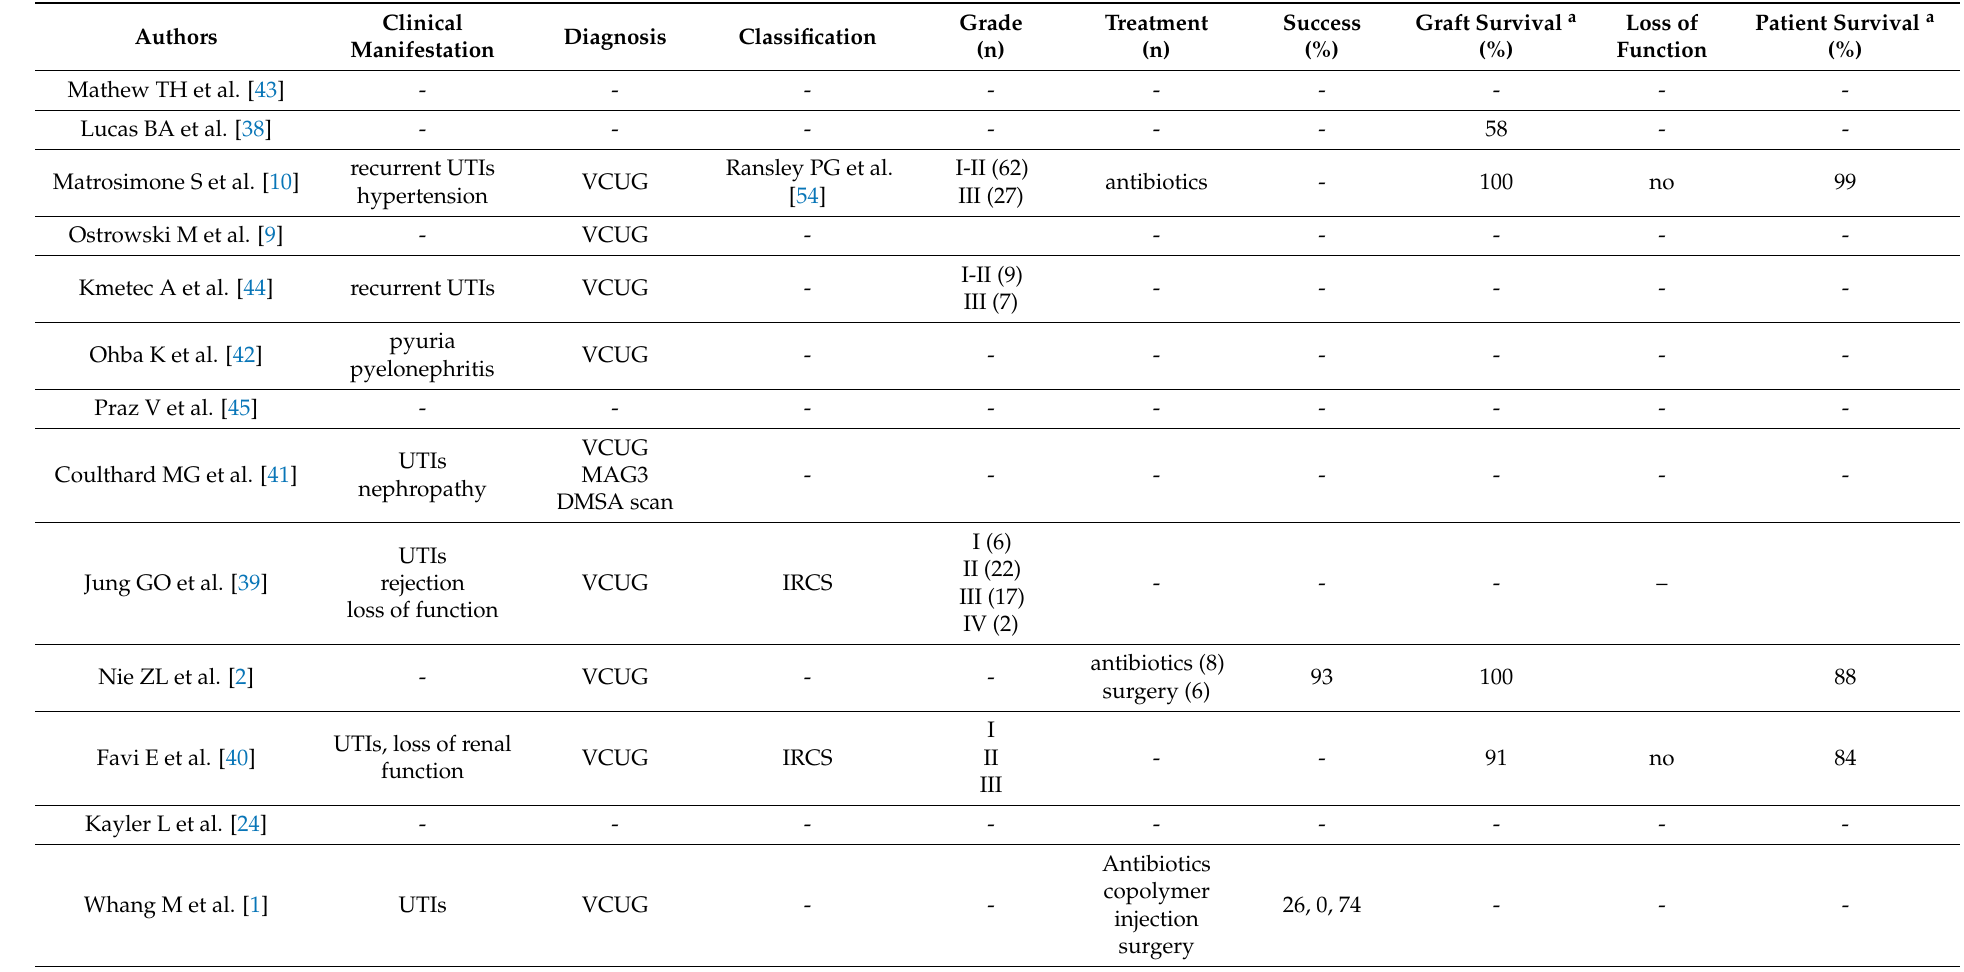
Table 4. Clinical features of kidney transplant recipients with vesicoureteral